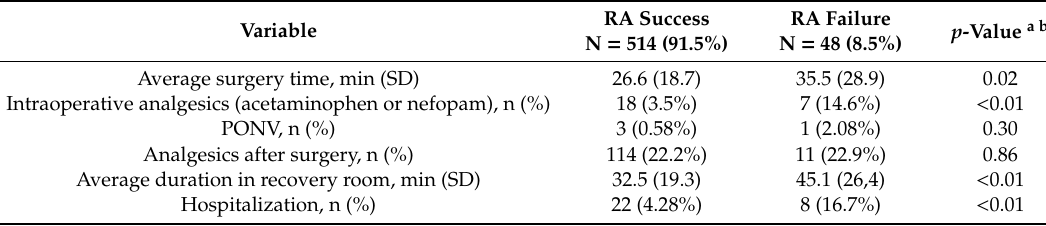
Table 2. Implication of regional anesthesia (RA) failure on the patient’s journey: analysis of surgical and anesthetic data during and after surgery.